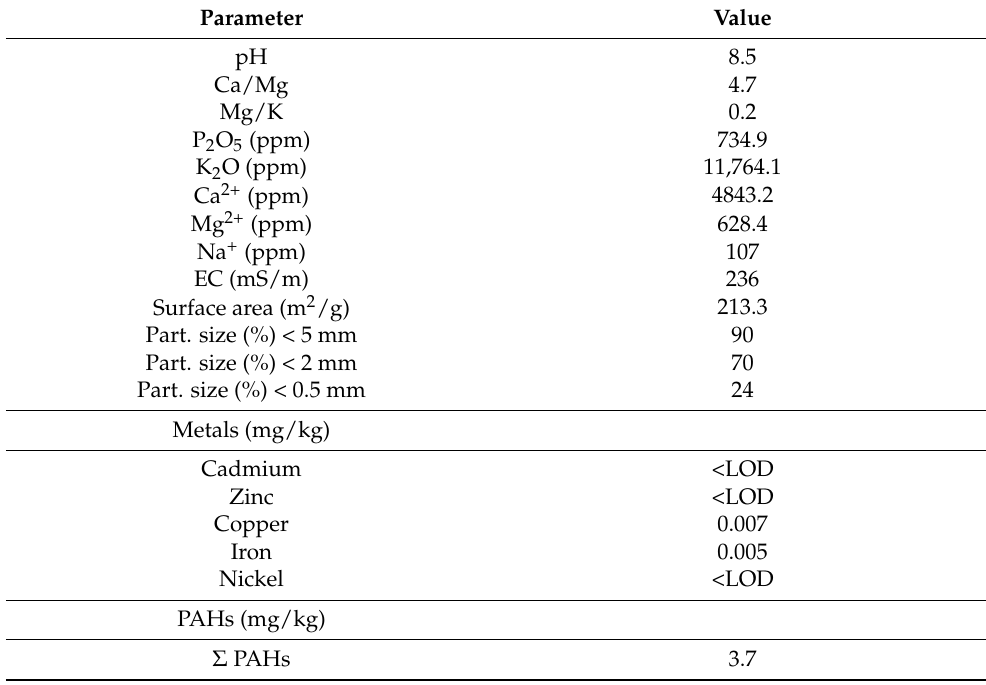
Table 3. Mean values of chemical analysis of the BC produced from wood derived from deciduous trees. Abbreviations: P 2 O 5 : assimilable phosphorus; K 2 O: available potassium; EC: electrical conduc- tivity; Part. size (%): particulate size %, i.e., percentage of biochar for the respective through-fraction (mm); LOD: limit of detection; Σ PAHs: polycyclic aromatic hydrocarbons content sum. Parameter Value pH 8.5